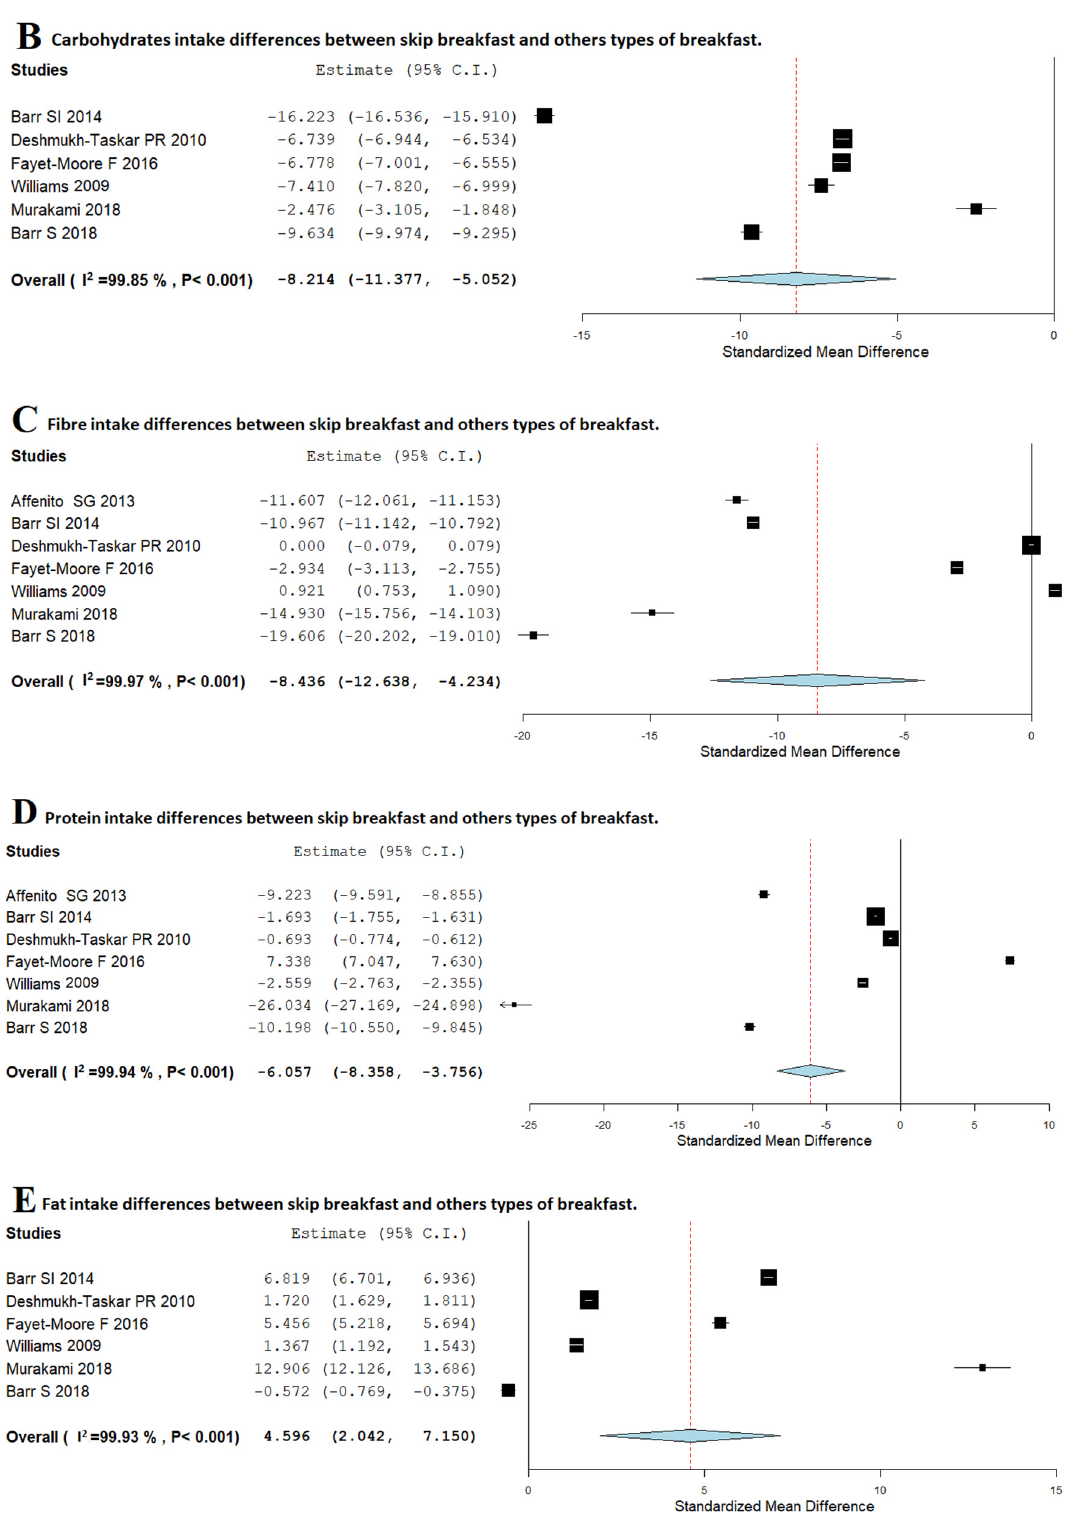
Figure 3. Random-effects meta-analysis of the effects of relationships between skipping breakfast and others types of breakfast regarding energy ( A ), carbohydrates ( B ), fibre ( C ), protein ( D ) and fat ( E ) intake.